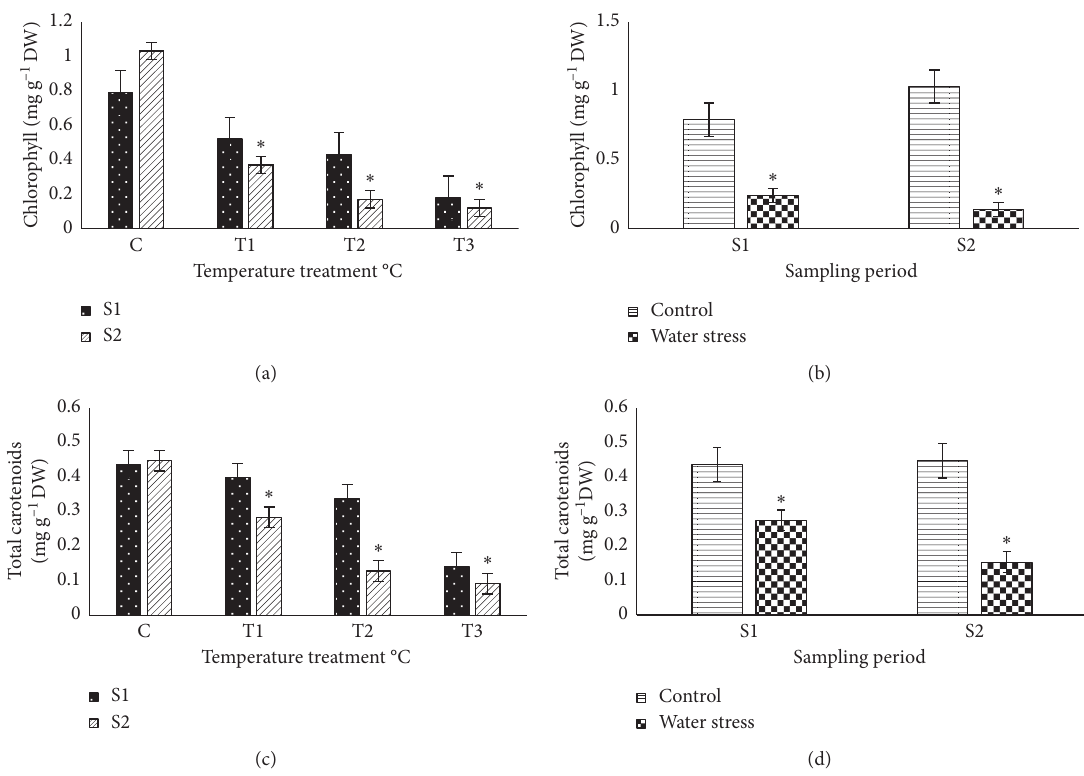
Figure 4: Effect of different climate temperatures (C, 25 ° C; T chlorophyll (a, b) and total carotenoids (c, d) after two sampling periods (S1, 14 days and S2, 21 days) in basil plants (mean ± SD, n � 10). Asterisks indicate significant differences between sampling periods of each treatment and differences between treatments for the same sampling period according to the Tukey test ( α �